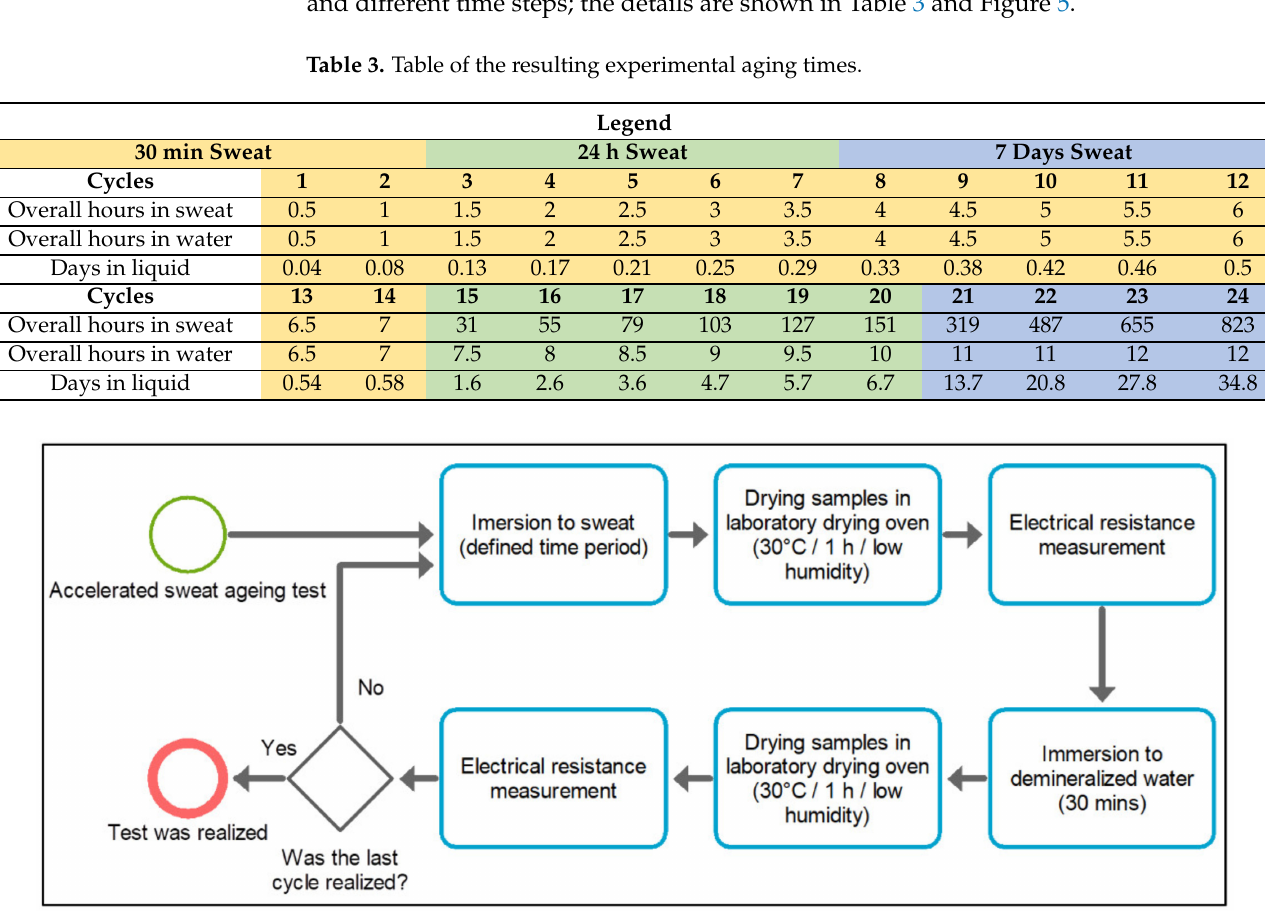
Figure 5. Procedure of conducting accelerated aging by artificial sweat